Question: What type of chart is this?
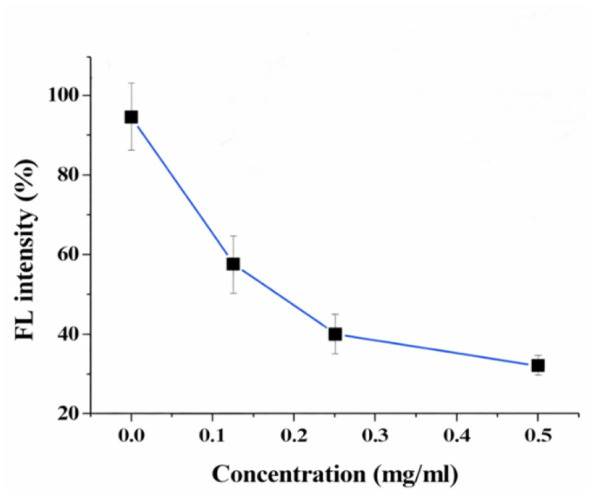
Answer: bar